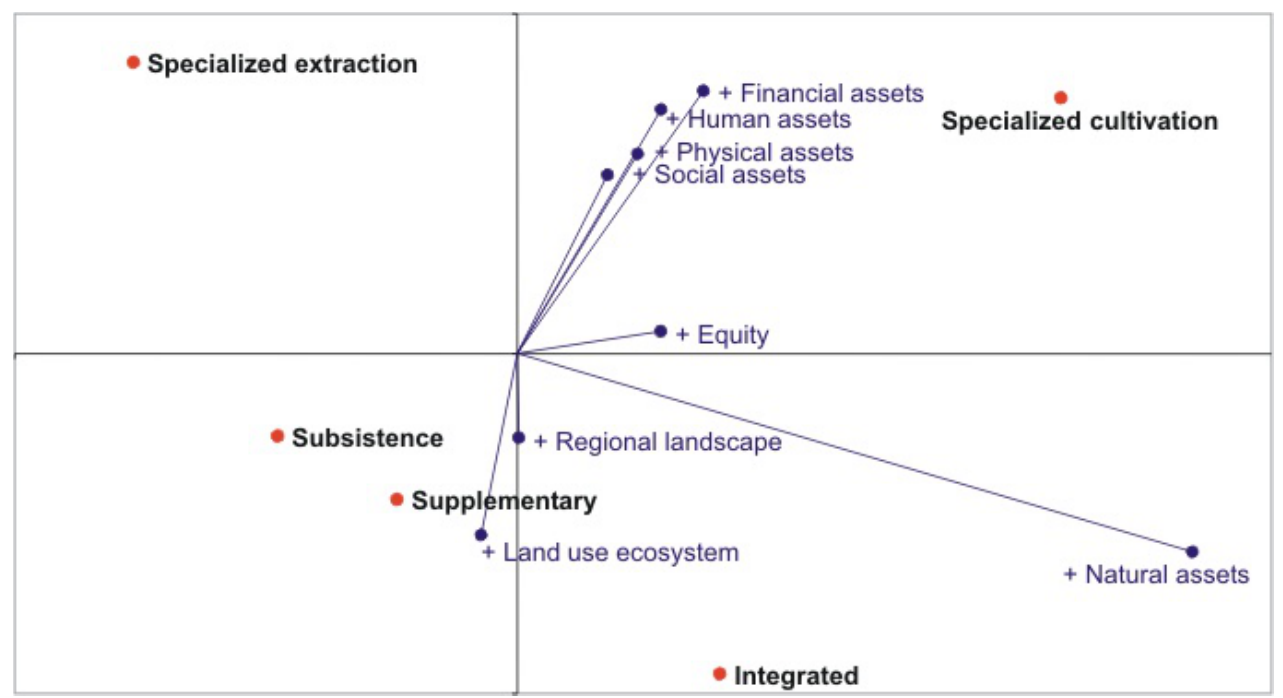
Fig. 7. Principle component analysis (PCA) plot of livelihood outcomes, environmental outcomes, and household strategies. The two dimensions of the PCA plot represent 96% of the data variability; the first dimension contributes 69% and the second dimension contributes